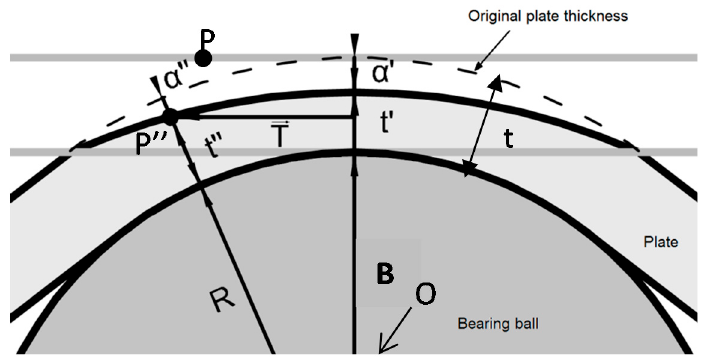
Figure 6. Sketch showing the adopted criteria to identify if a surface point is affected by thickness reduction due to contact.